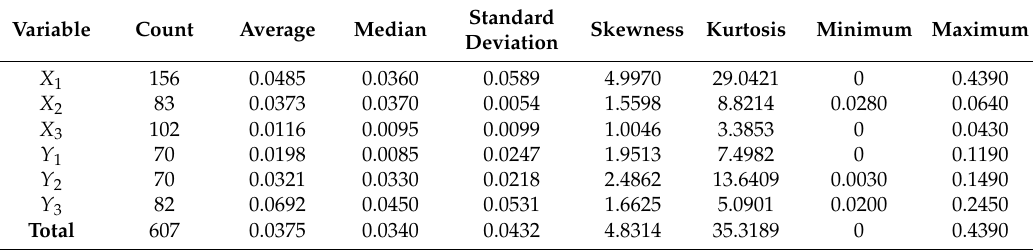
Table 1. Summary statistics.